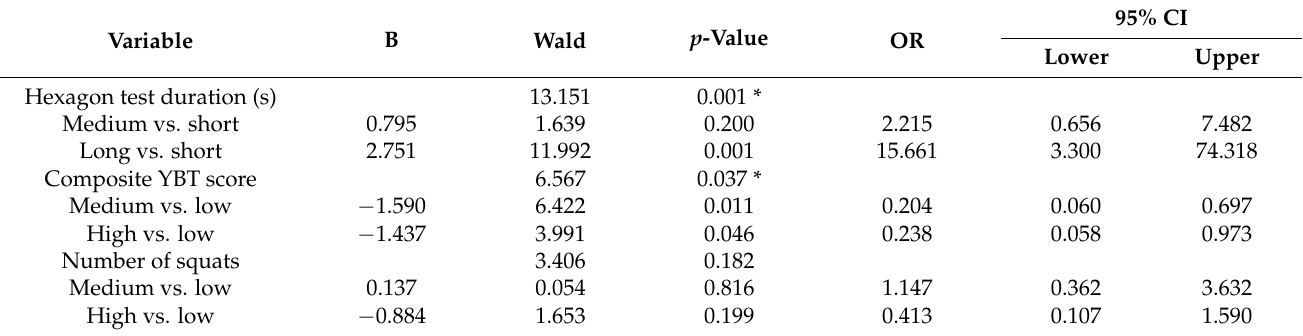
Table 5. Multivariate binary logistic regression